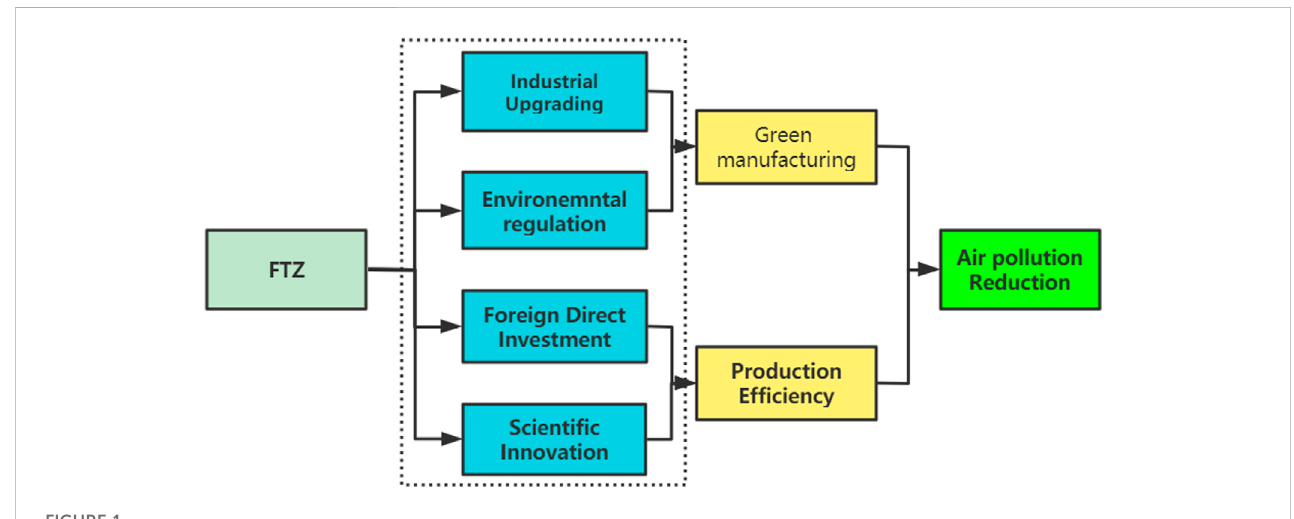
Mechanism fl ow